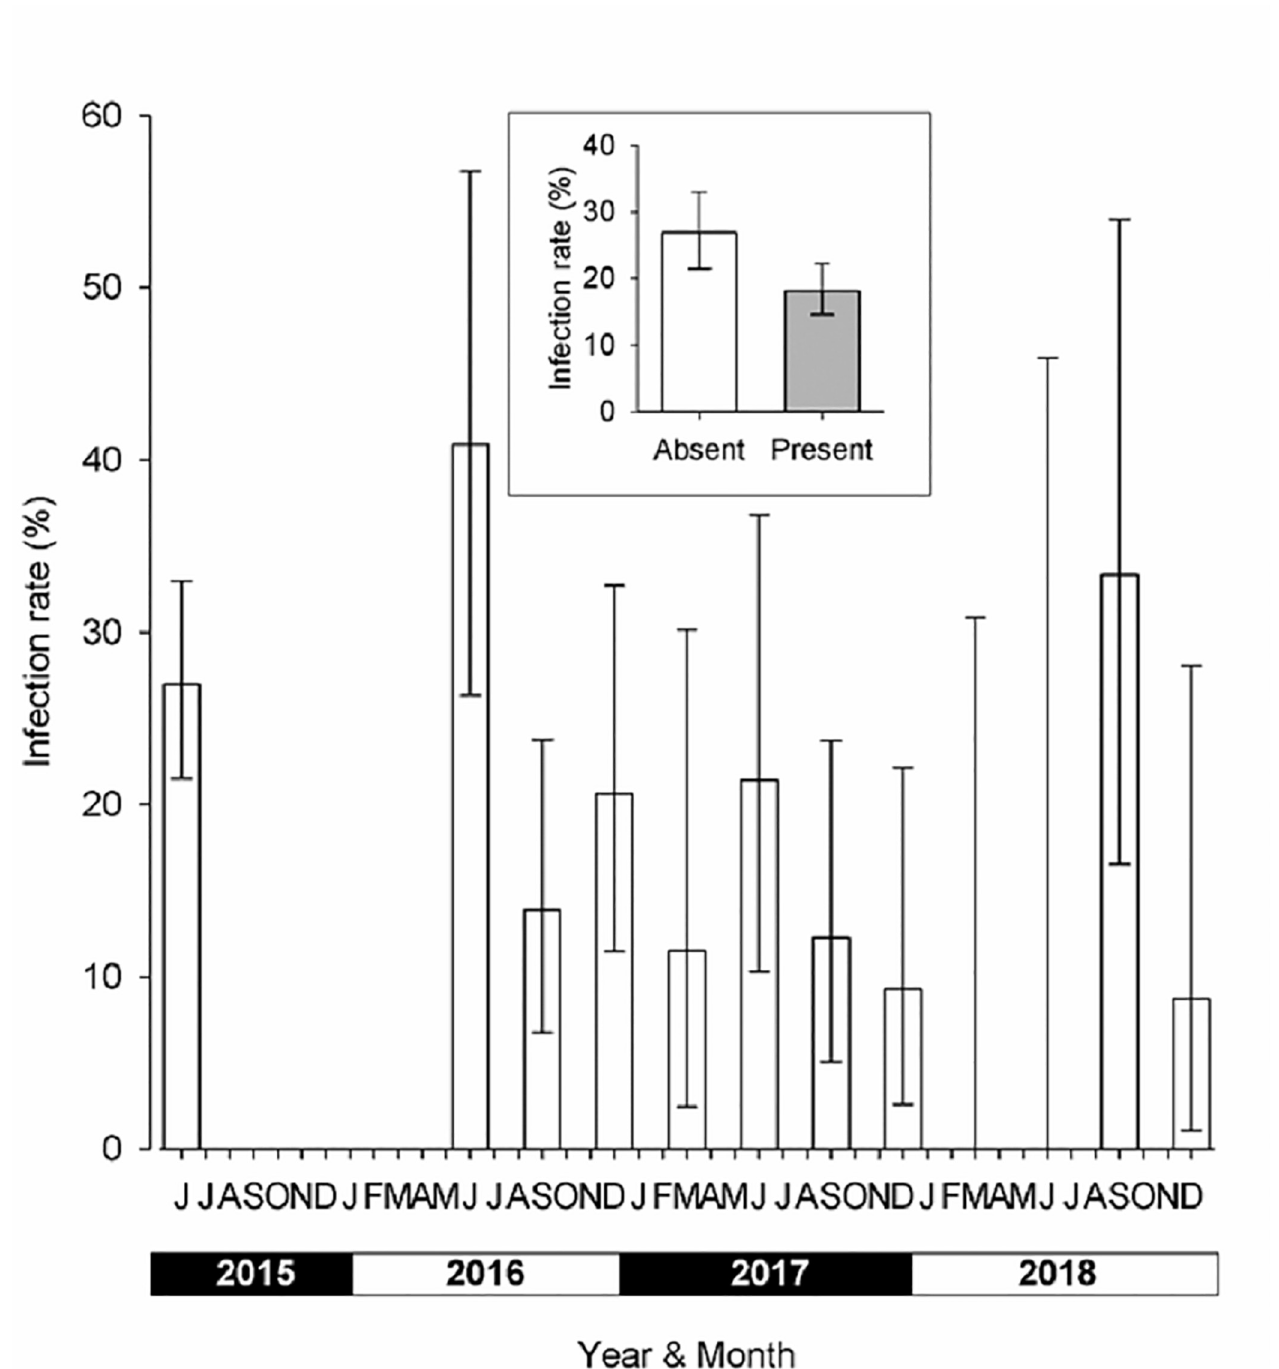
Fig 6. Percentage ( ± 95%CI) of tsetse infected with trypanosomes. Inset shows percentages when targets were absent or present from the intervention